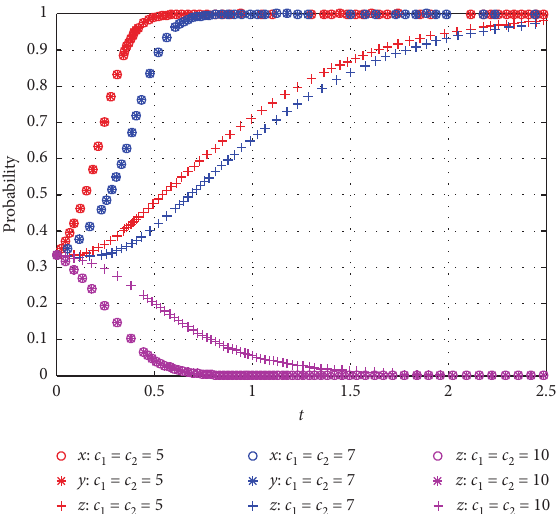
Figure 7: Evolution paths of scenario 4 under different costs.